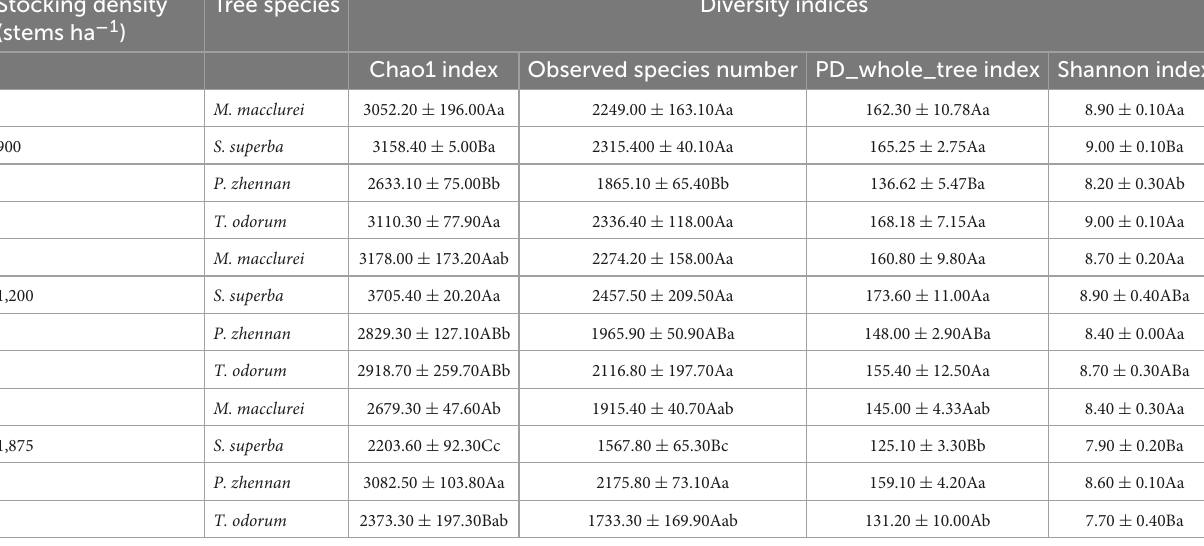
TABLE 5 Bacterial diversity in the rhizosphere soil of four broad-leaved trees planted under different stocking densities. Stocking density